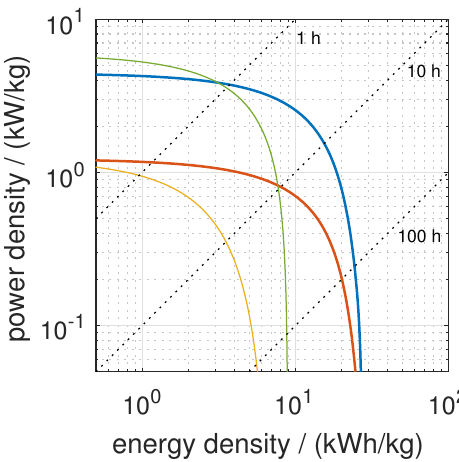
Figure 7. Ragone plot of current and future fuel cell systems for aviation. Yellow: current fuel cells with 1.6 kW/kg incl. periphery, current electric engines with 5.2 kW/kg and simple stationary tanks. Red: current fuel cells+periphery and electric engines with LH2 tanks optimized for medium-haul flight. Blue: future lightweight, high-power fuel cells+periphery with 8 kW/kg, future electric engines with 10 kW/kg and optimized LH2 tanks. Green: current system of jet engine (Airbus A320) and kerosene tanks. Dotted lines mark time constants of 1 h (top), 10 h (middle), and 100 h